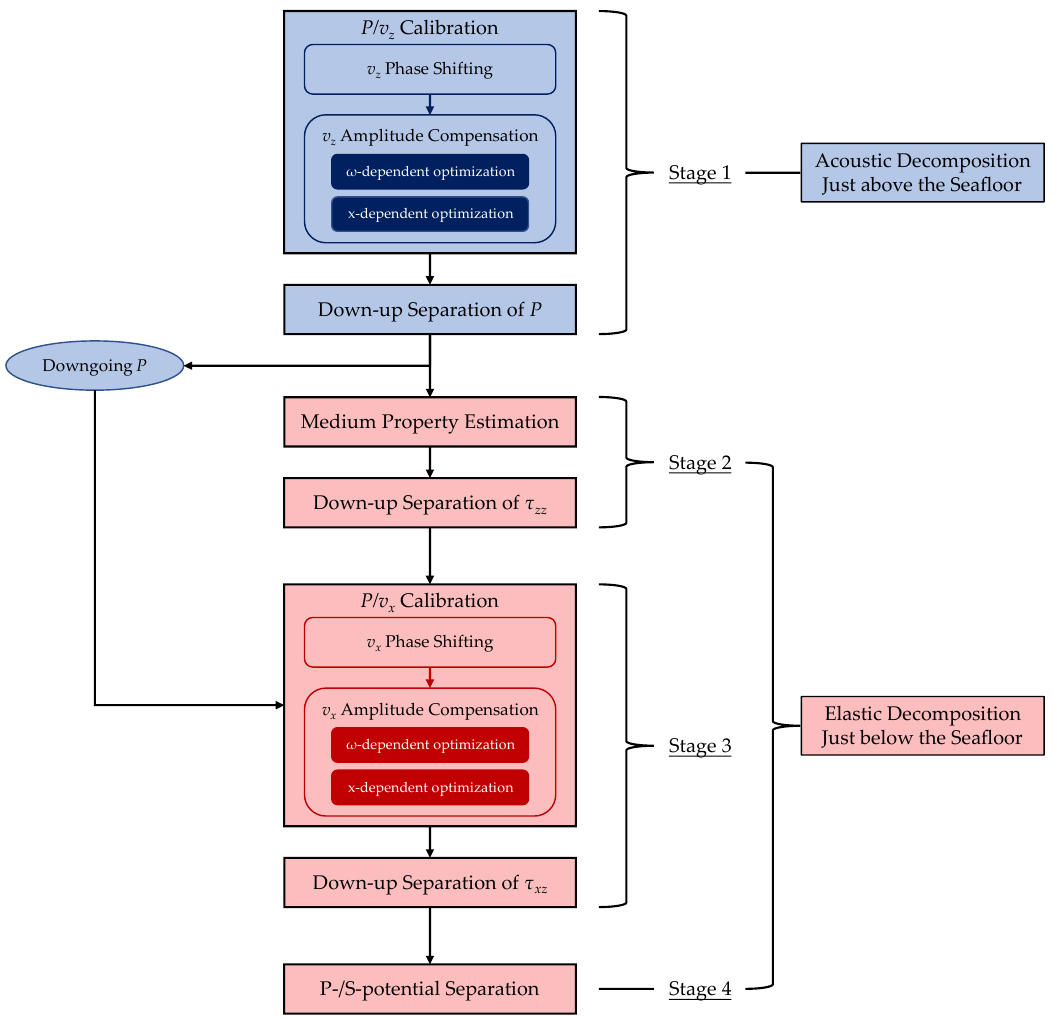
Figure 2. The workflow of our modified adaptive decomposition scheme with composite calibration filters. Steps related to acoustic decomposition above the seafloor are painted blue, and steps related to elastic decomposition below the seafloor are painted red.